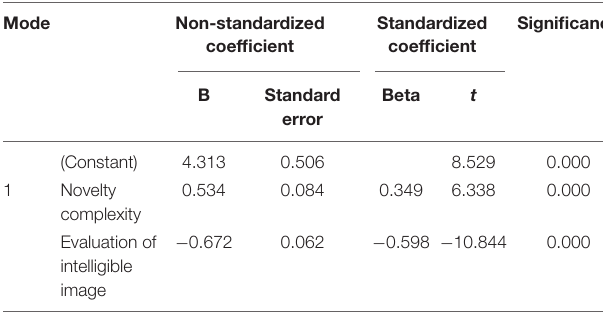
TABLE 6 | Coefficients a .